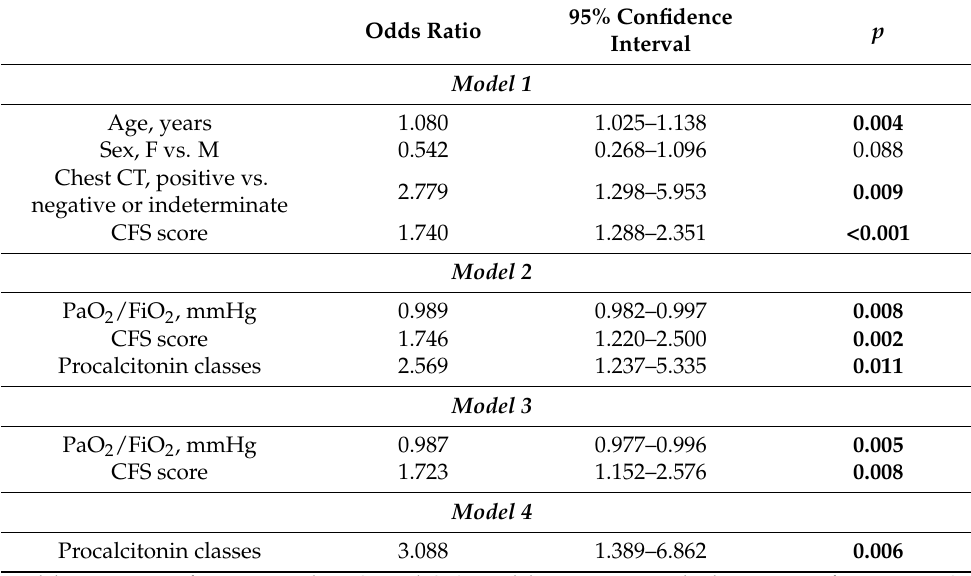
Table 4. Logistic regression models exploring factors independently associated with mortality in the studied population. Odds